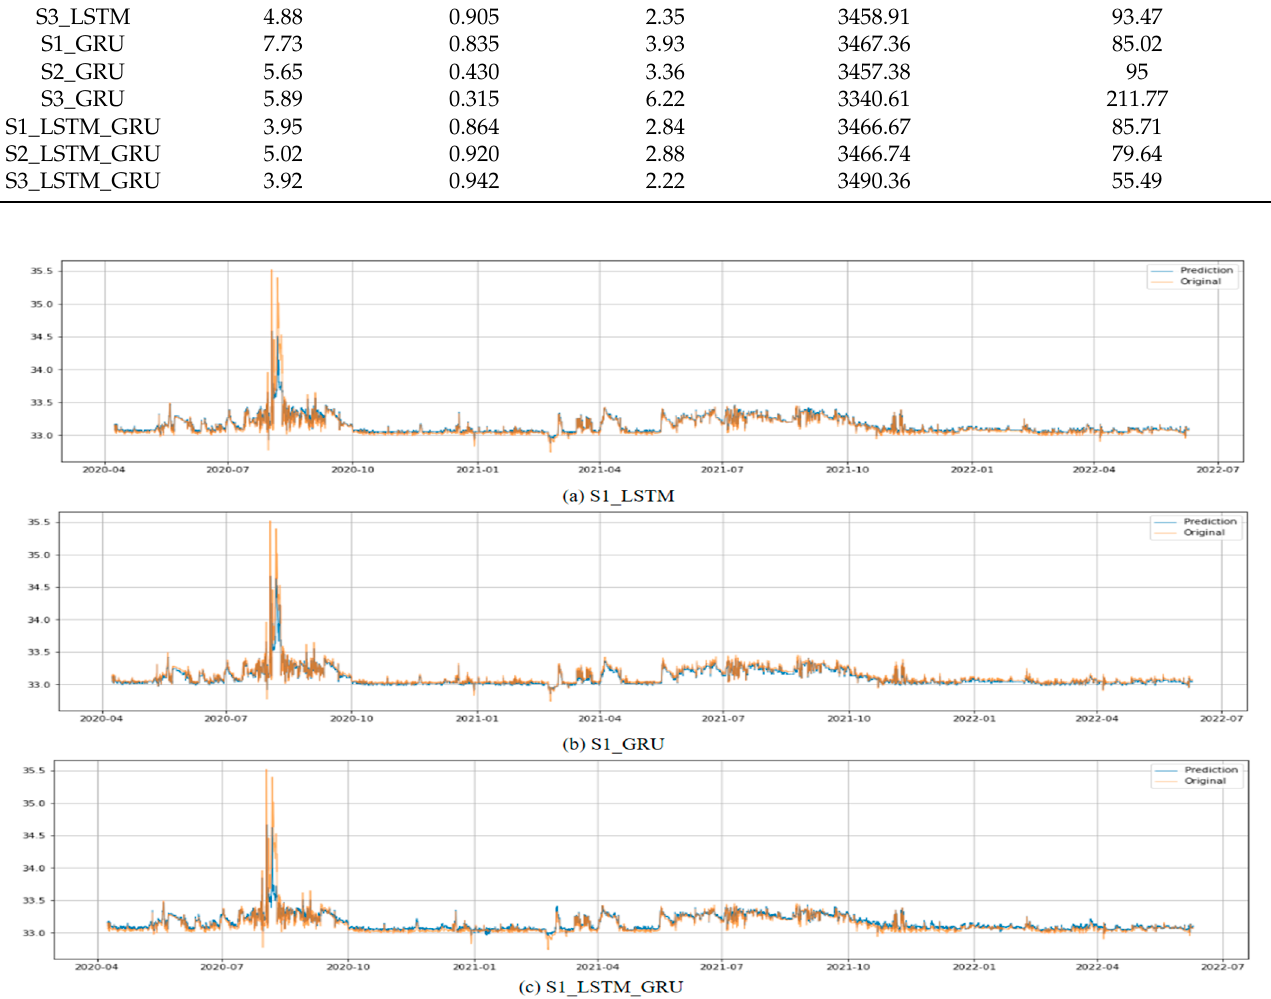
Figure 15. Comparison graph of observed and predicted values for each model in S1 case. ( a ) Multi-LSTM; ( b ) multi-GRU; and ( c ) LSTM–GRU.